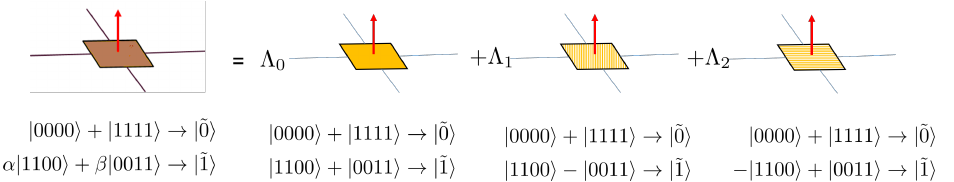
Figure 5. Tensor of a noisy 4-qubit code and how it breaks down as a superposition of different stabilizer codes. The corresponding encoding maps are given below each